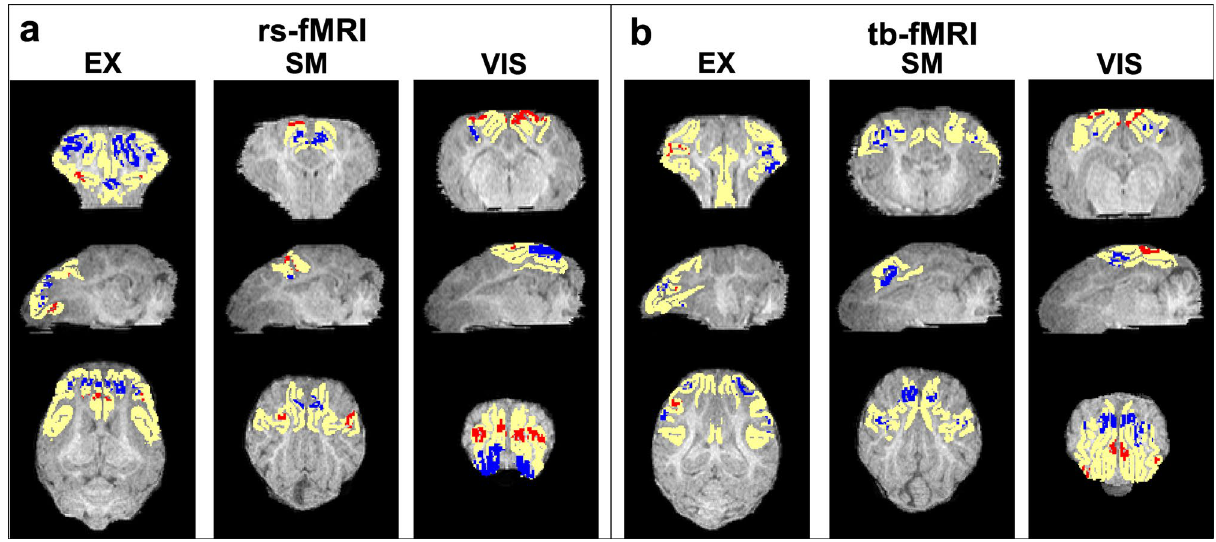
Figure 8. Permutation maps generated from sDL analysis. Representative images of two-dimensional permutation maps from the resting-state (rs-; a ) and task- based (tb-; b ) fMRI analysis for the visual (VIS), executive control (EX), and sensorimotor (SM) networks and their corresponding reference atlases (yellow) overlaid on the template pigs’ T1-weighted anatomical image. The blue indicates voxels with significantly decreased activation values of the TBI group in comparison to the control group, and red indicates significantly increased activation